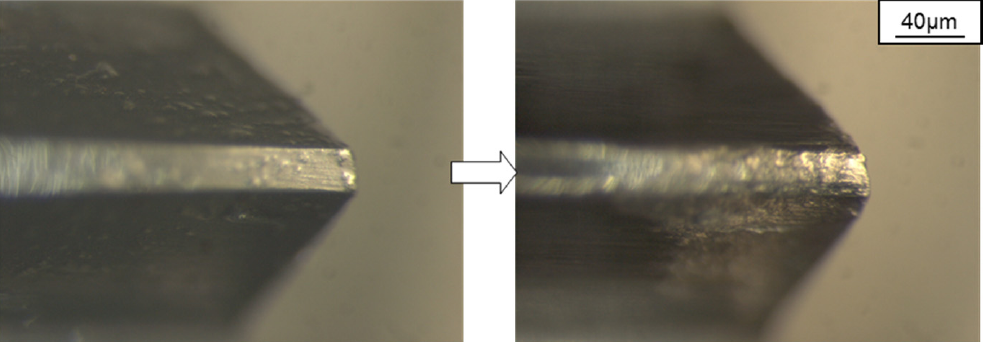
Figure 11. Average evolution of % A in the teeth of uncoating tap.